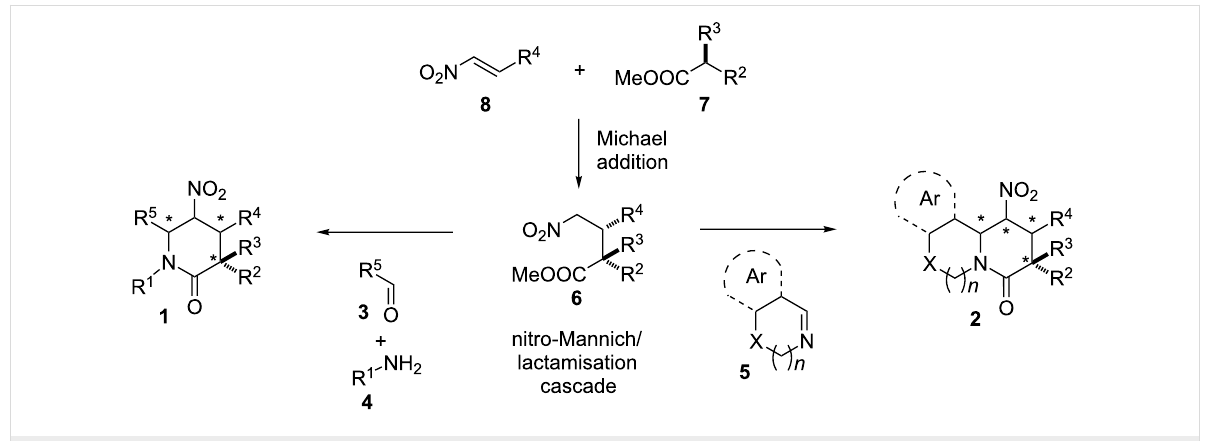
Scheme 1: A general strategy to 5-nitropiperidin-2-ones and related heterocycles.